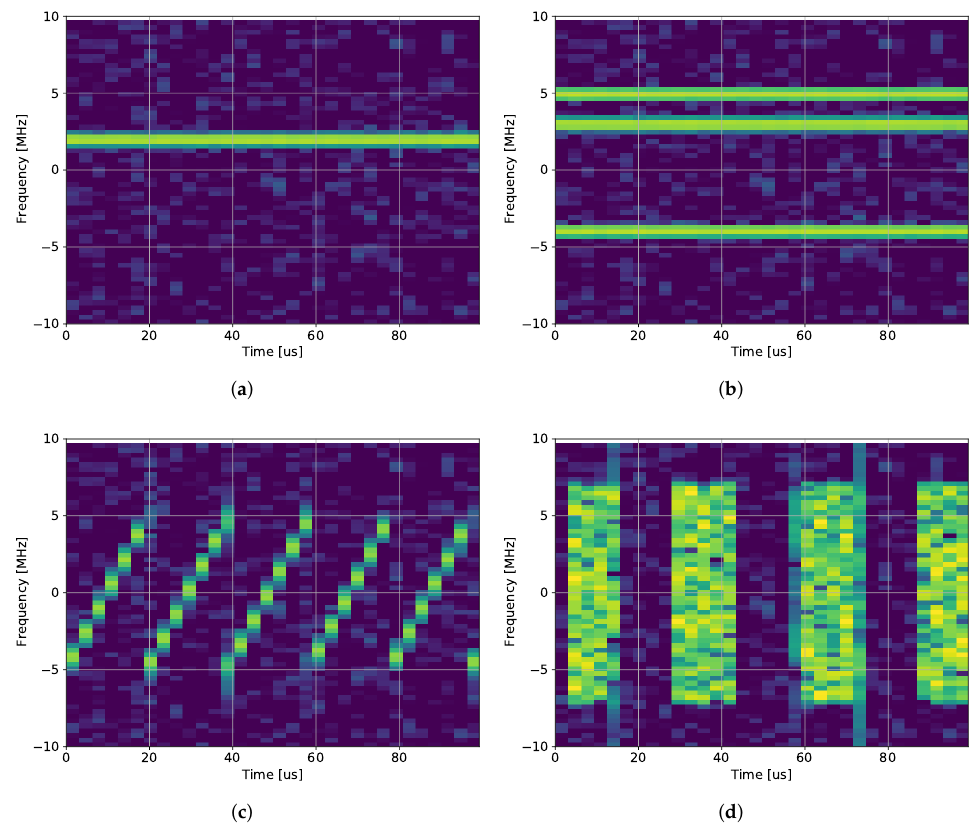
Figure 2. Classification example of different waveform types, showing the spectrograms. Yellow is high power and blue is low power, the signals are: ( a ) Single-tone, ( b ) Multitone, ( c ) Chirp, and ( d ) Pulsed